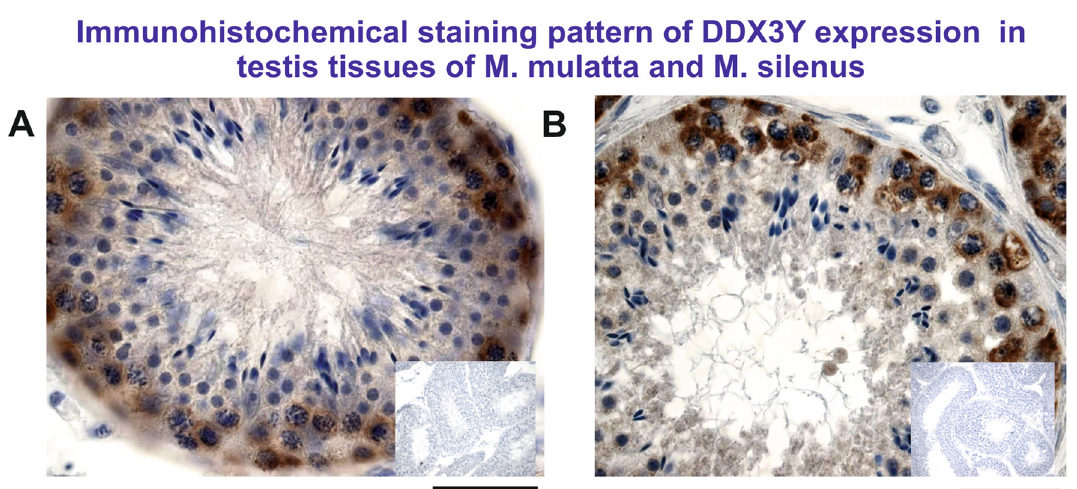
Figure 5. Immunohistochemical staining pattern of DDX3Y expression in testis tissue sections of Macaca mulatta ( A ) and Macaca silenus ( B ) revealed predominant and similar expression in the premeiotic male germ cells of both old world monkeys. Inserts at the right display immunostaining patterns with the pre-immune serum on overview pictures of serial sections from the same testis tissues specimen. Scale bars: 50